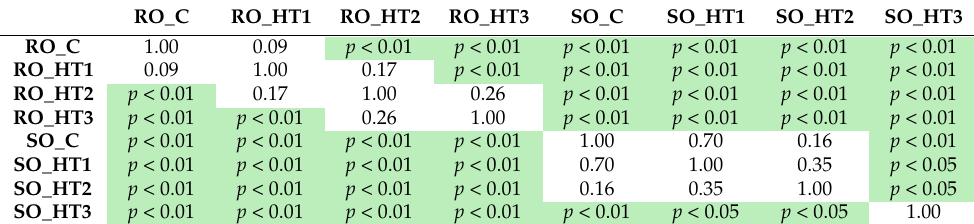
Table 3. Matrix with the p -values of the Hotelling’s T 2 tests for each pair of fortified oil groups (quantitative descriptive